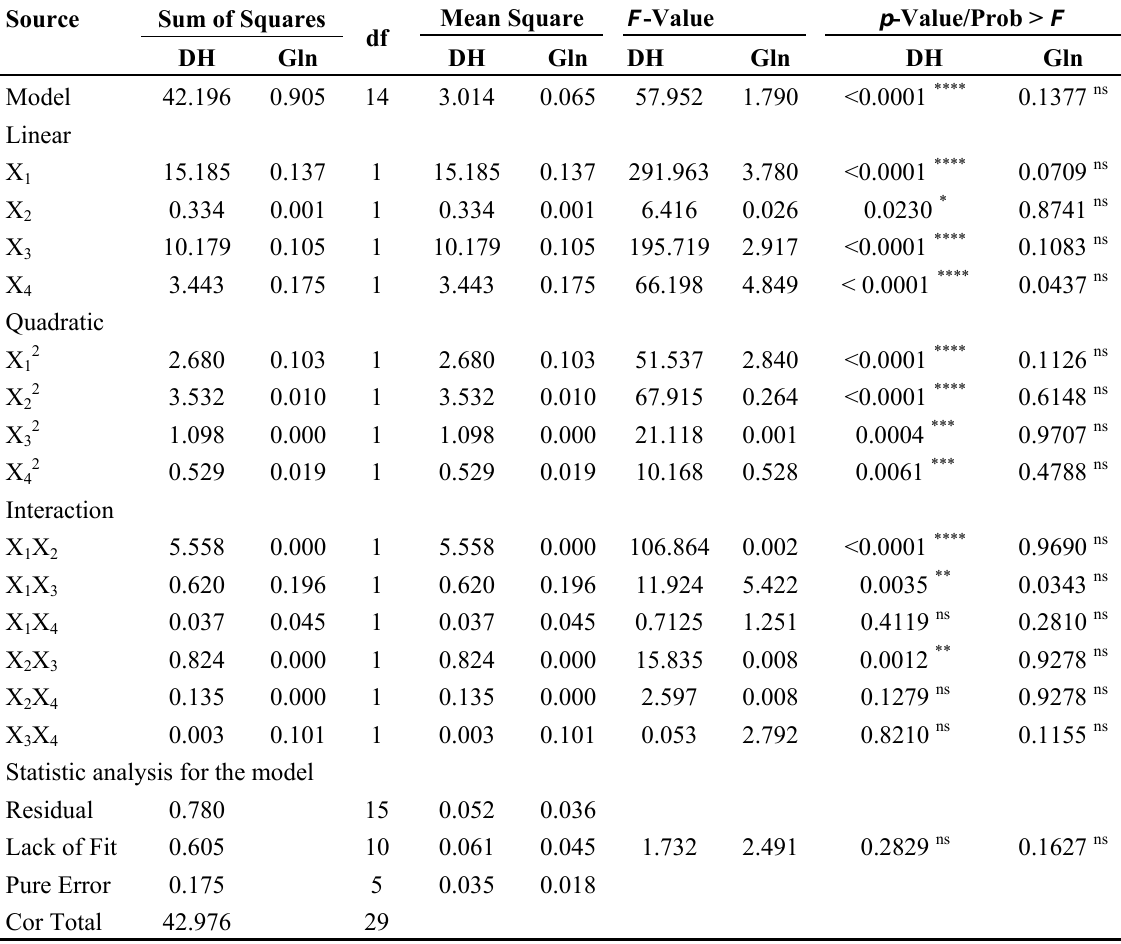
Table 2. Significance of regression coefficients for degree of hydrolysis (DH) and glutamine (Gln)